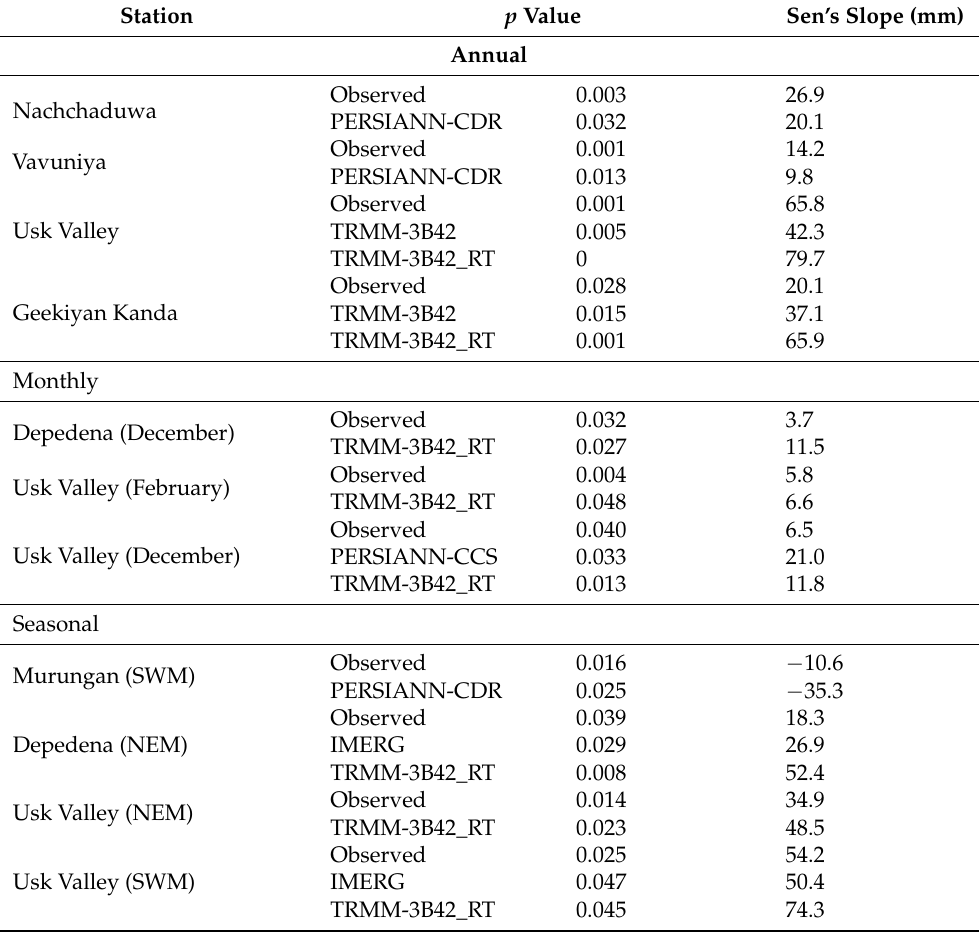
Table 7. Significant